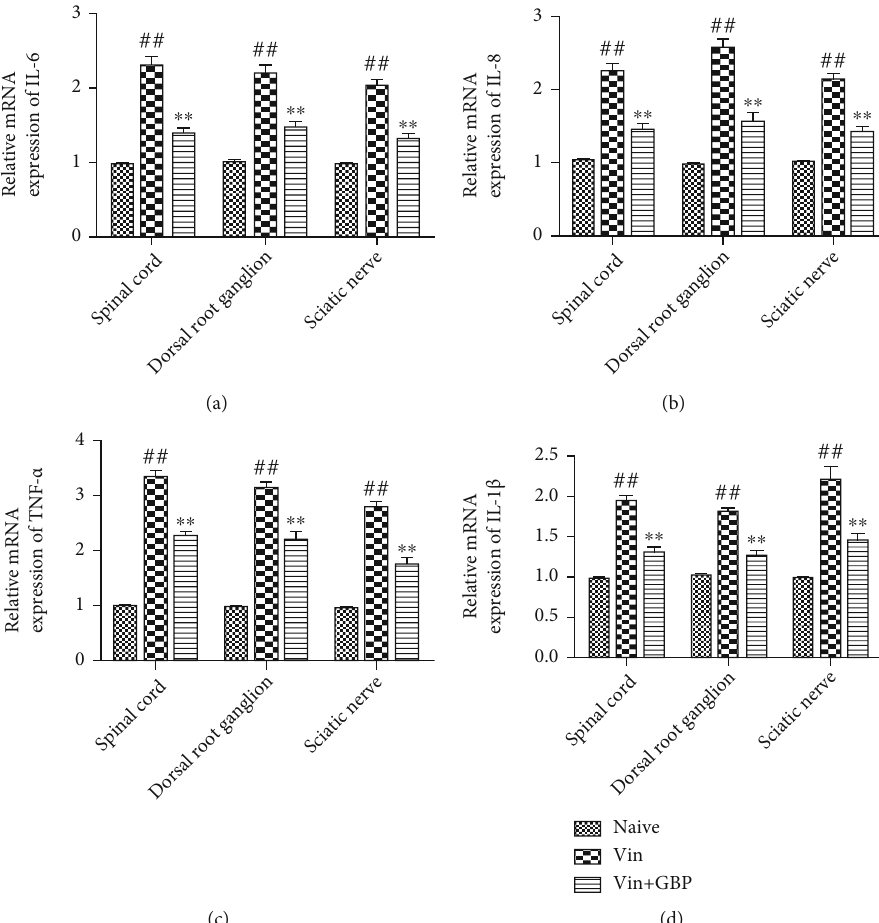
Figure 7: E ff ects of G. elata polysaccharide (GBP) administration on the mRNA expression of proin fl ammatory cytokines in the sciatic nerve, spinal cord, and dorsal root ganglion (DRG). After completion of the pain behavioral tests on day 21, sciatic nerve, spinal cord, and dorsal root ganglion (DRG) were collected. mRNA expression of IL-6 (a), IL-8 (b), TNF- α (c), and IL-1 β (d) was measured. Data were expressed as the mean ± SD ( n = 6 for each group). # P < 0 : 01 : vs. naive group; ∗∗ P < 0 : 01 : vs Vin group. One-way ANOVA followed by Bonferroni ’ s post hoc